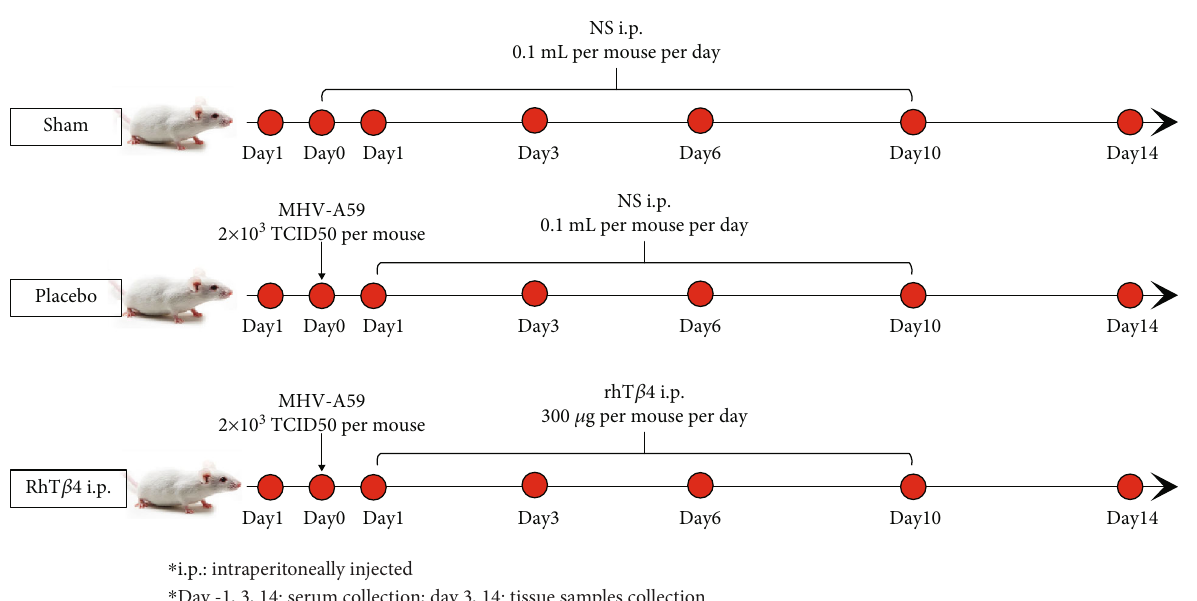
Figure 1: Process of mice experiment. Each of the mice in the sham group was intraperitoneally injected with 0.1mL of normal saline (NS) daily from days 0 to 10. The mice in the placebo group were each intraperitoneally injected with 2 × 10 3 TCID 0.1mL NS was intraperitoneally injected into each mouse once daily from days 1 to 10. The mice in the rhT β 4 group were intraperitoneally injected with 2 × 10 3 TCID of MHV-A59 per mouse on day 0, and 300 μ g of rhT β 4 in 0.1mL NS was intraperitoneally injected per mouse 50 daily from days 1 to 10. The mice in each group were observed until day